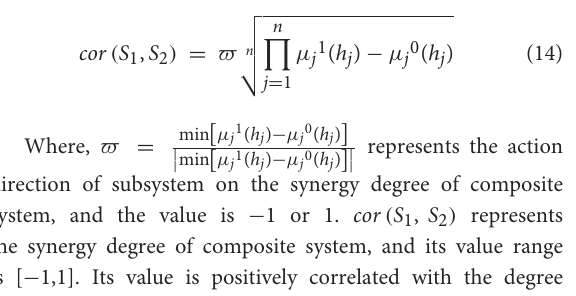
TABLE 2 Criteria for the coupling level between low-carbon development and socio-economic development.